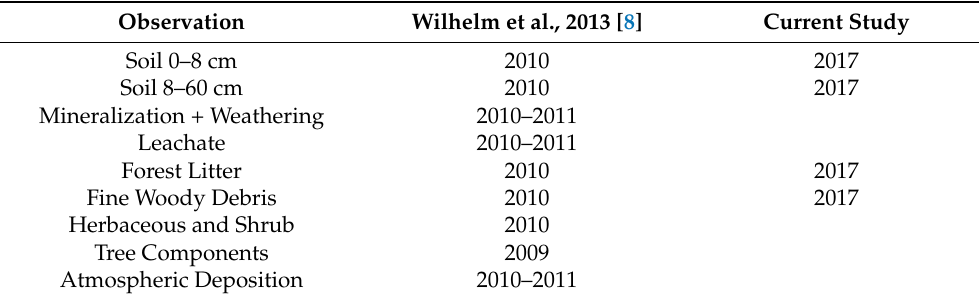
Table 1. Summary of nutrient observations from the original and current study investigating effects from a harvest in